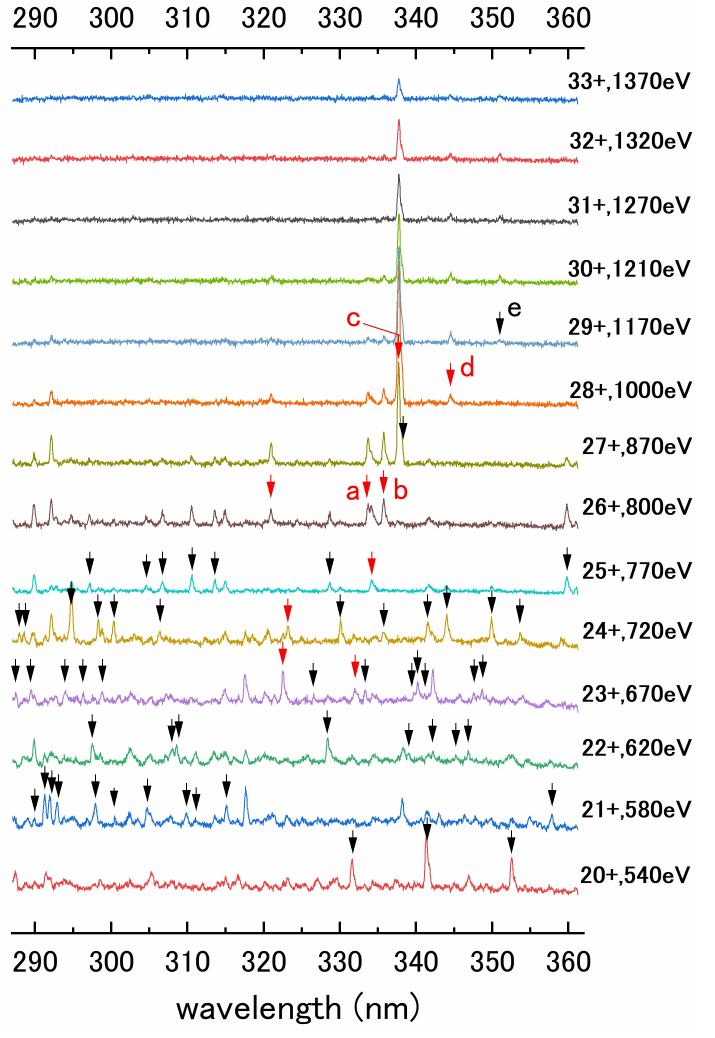
Figure 2. Emission line spectra for 290–360 nm of W q + ions in CoBIT-II. The electron beam energy and the highest charge state produced at the energy, q max , are written at the right of each spectrum. Arrows in each spectrum indicate the emission lines of the ions in the charge state. Each spectrum was measured for 20 min exposure